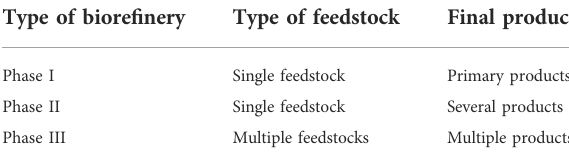
TABLE 1 Types of biore fi neries according to number of feedstocks processed and number of products